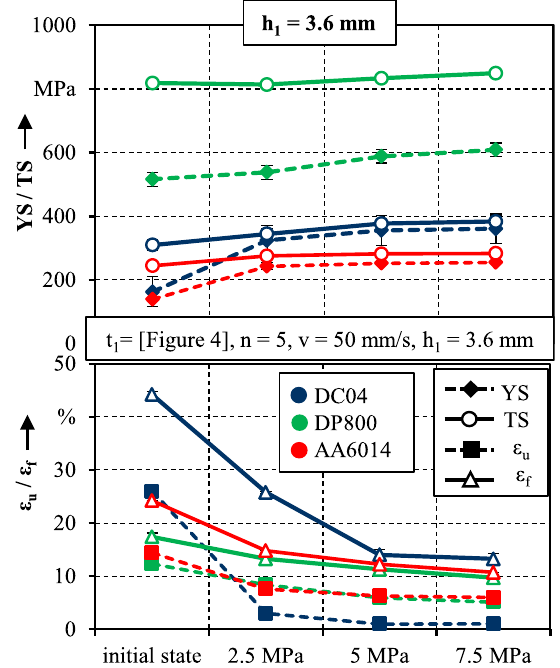
Fig. 7. Tensile test parameters after a drawbead h 1 with variation of the blankholder pressure between p N =2.5MPa and 7.5 MPa ( h 1 =3.6 mm, v =50